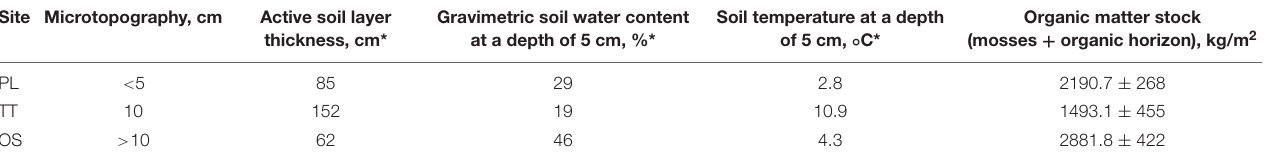
TABLE 2 | Site soil properties. Site Microtopography,